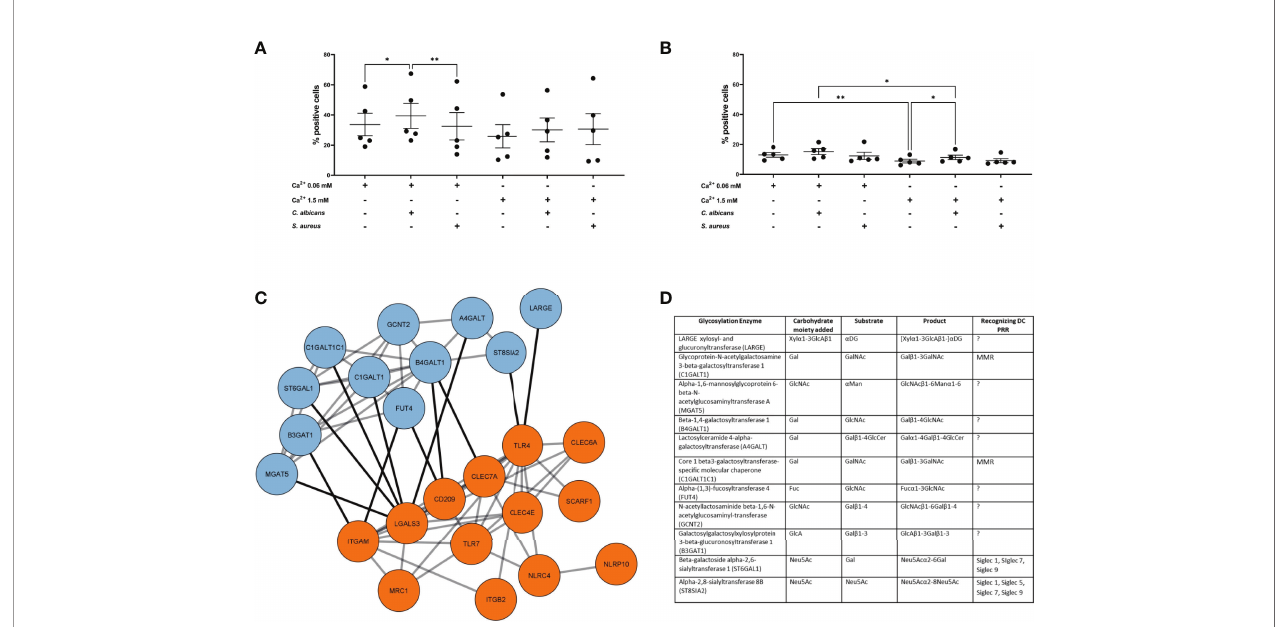
FIGURE 3 | AD milieu and C albicans exposure affects sEV NHEK -cell interaction by interfering with glycosylation enzyme network in keratinocytes. (A) iMDDC interaction with sEV NHEK under combined AD cytokine/pathogen stimulation; data pooled from n=5 donors; (B) mMDDCs interaction with sEV NHEK under combined AD cytokine/ pathogen stimulation; data pooled from n = 5 donors; *p < 0.05; **p < 0.01 (A-B: one-way ANOVA), means and SEM are shown; N.B. some comparisons with signi fi cant p-values are not labelled for the clarity of the graph; (C) STRING analysisofthe protein networks between C. albicans -stimulated signallingfrom pattern recognition receptors inhuman keratinocytes (PRRs; inorange) and linked glycosylation-relevant enzymes (in blue); (D) Carbohydrate moiety/substrate/product-speci fi city ofglycosylation enzymes identi fi ed in the network linked to C. albicans -speci fi c PRRs (full list, includingreferences in Table S3 );DC, Dendriticcell; PRR, Patternrecognition receptor; PAMP, Pathogen associated molecular pattern; LacNAc, N-acetyllactosamine; GalNAc, N-acetylglucosamine; GlcNAc, N-acetylglucosamine; Fuc, Fucose; Gal,Galactose; Man, Mannose; Neu5Ac, N-acetylneuraminic acid; MMR,Macrophage mannose receptor; MGL, Macrophagegalactose type lectin; DCIR,Dendriticcell immunoreceptor; BDCA2, Blood dendriticcallantigen 2; CLEC, C-typelectin domain family; Siglec, sialic